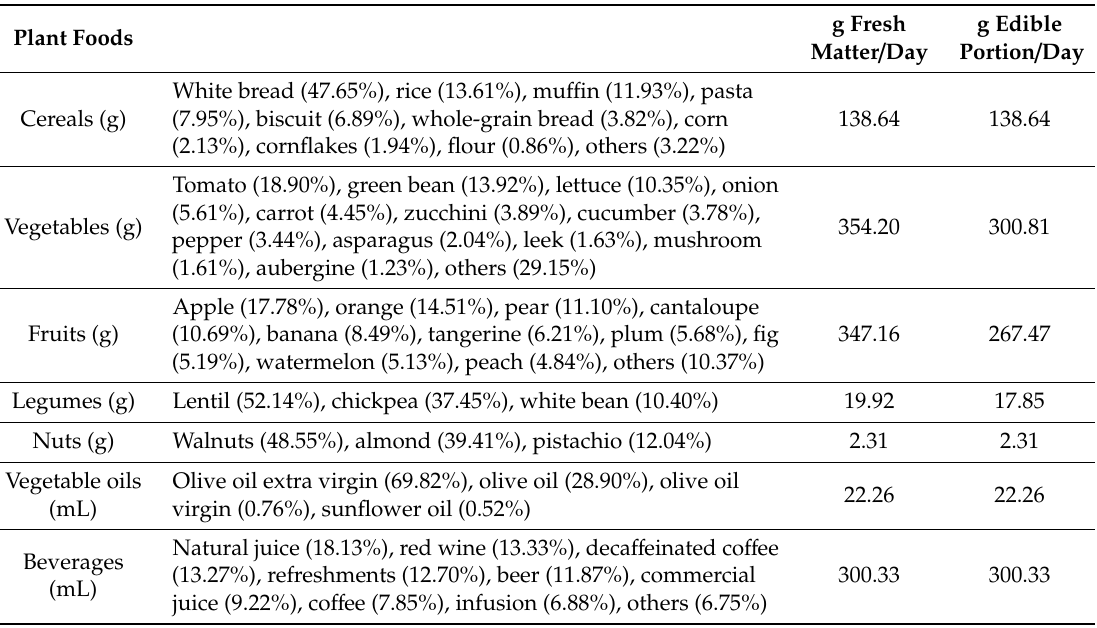
Table 1. Consumption of plant foods, oils and beverages in an elderly Mediterranean population aged over